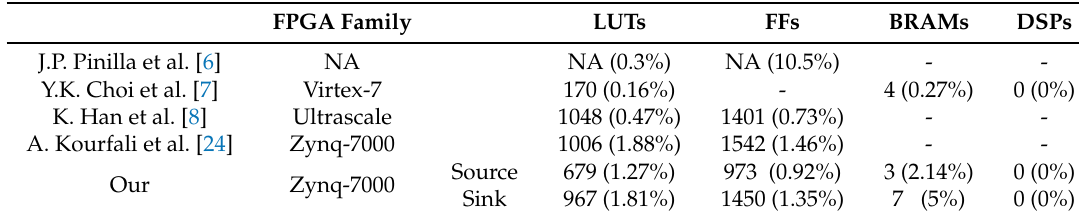
Table 3. Breakdown of hardware resource